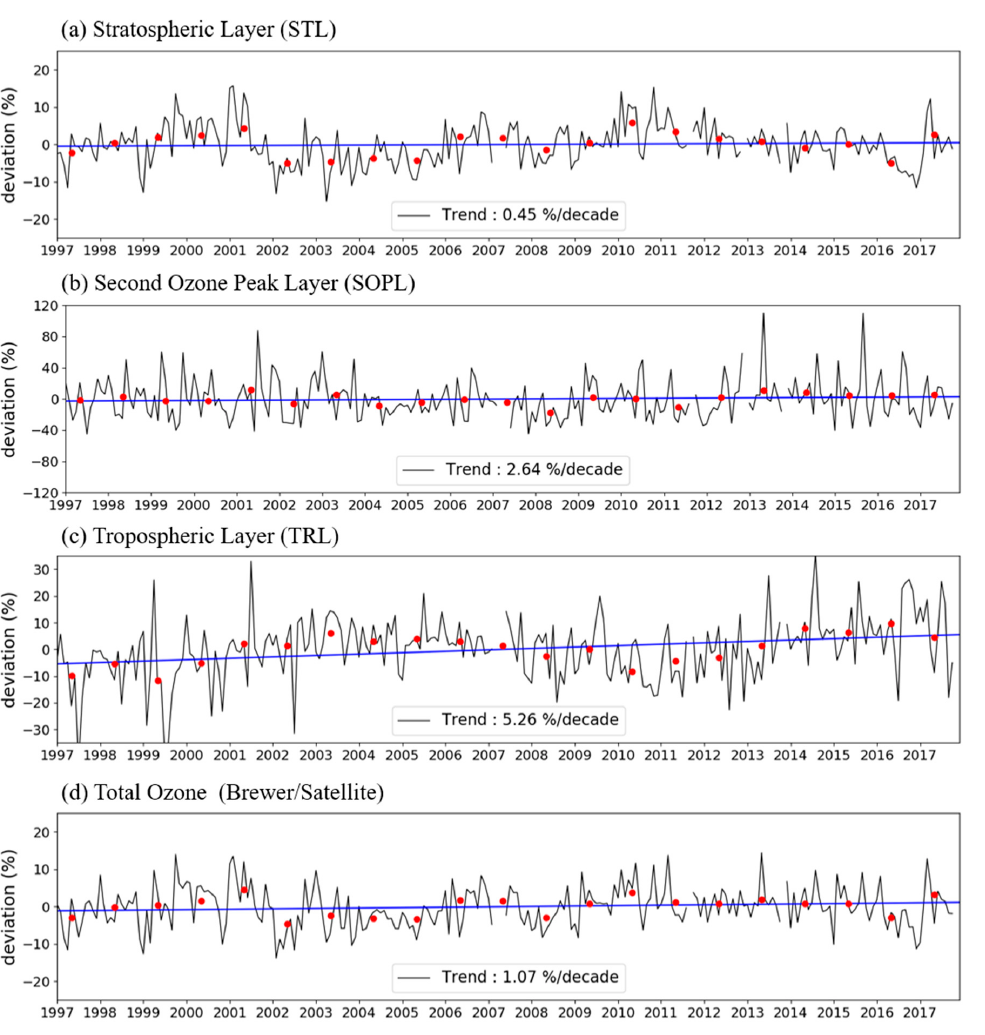
Figure 1. Time series of percent deviations in deseasonalized average ozone (DU) for three layers—( a ) Stratospheric layer, ( b ) Second ozone peak layer, ( c ) Tropospheric layer and ( d ) the total column. The blue line and red dots represent the trend and annual mean of each layered ozone,